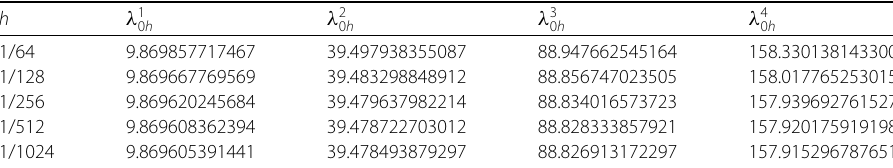
Table 1 a = 0, the four eigenvalues with l = 0 and h